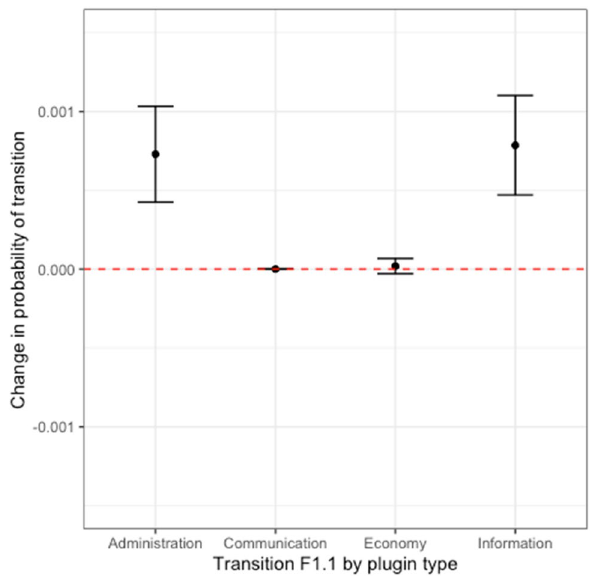
Figure 3. Evidence for correlations between similarities in cultural and institutional development between two communities, a common trend was for an increase from communities with low similarity to high similarity in both membership and rule type, in the administrative and informational rules among the four rule types (Transition F1.1). This figure represents those link changes from Fig. 1 that demonstrate the existence of “cross- layer” influence between our rule and cultural networks.